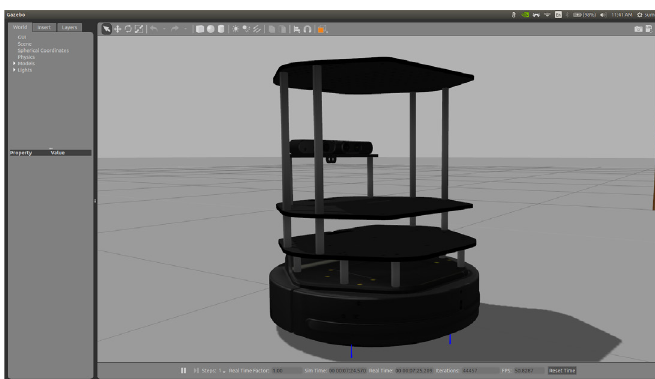
Fig. 1: Turtlebot model in gazebo